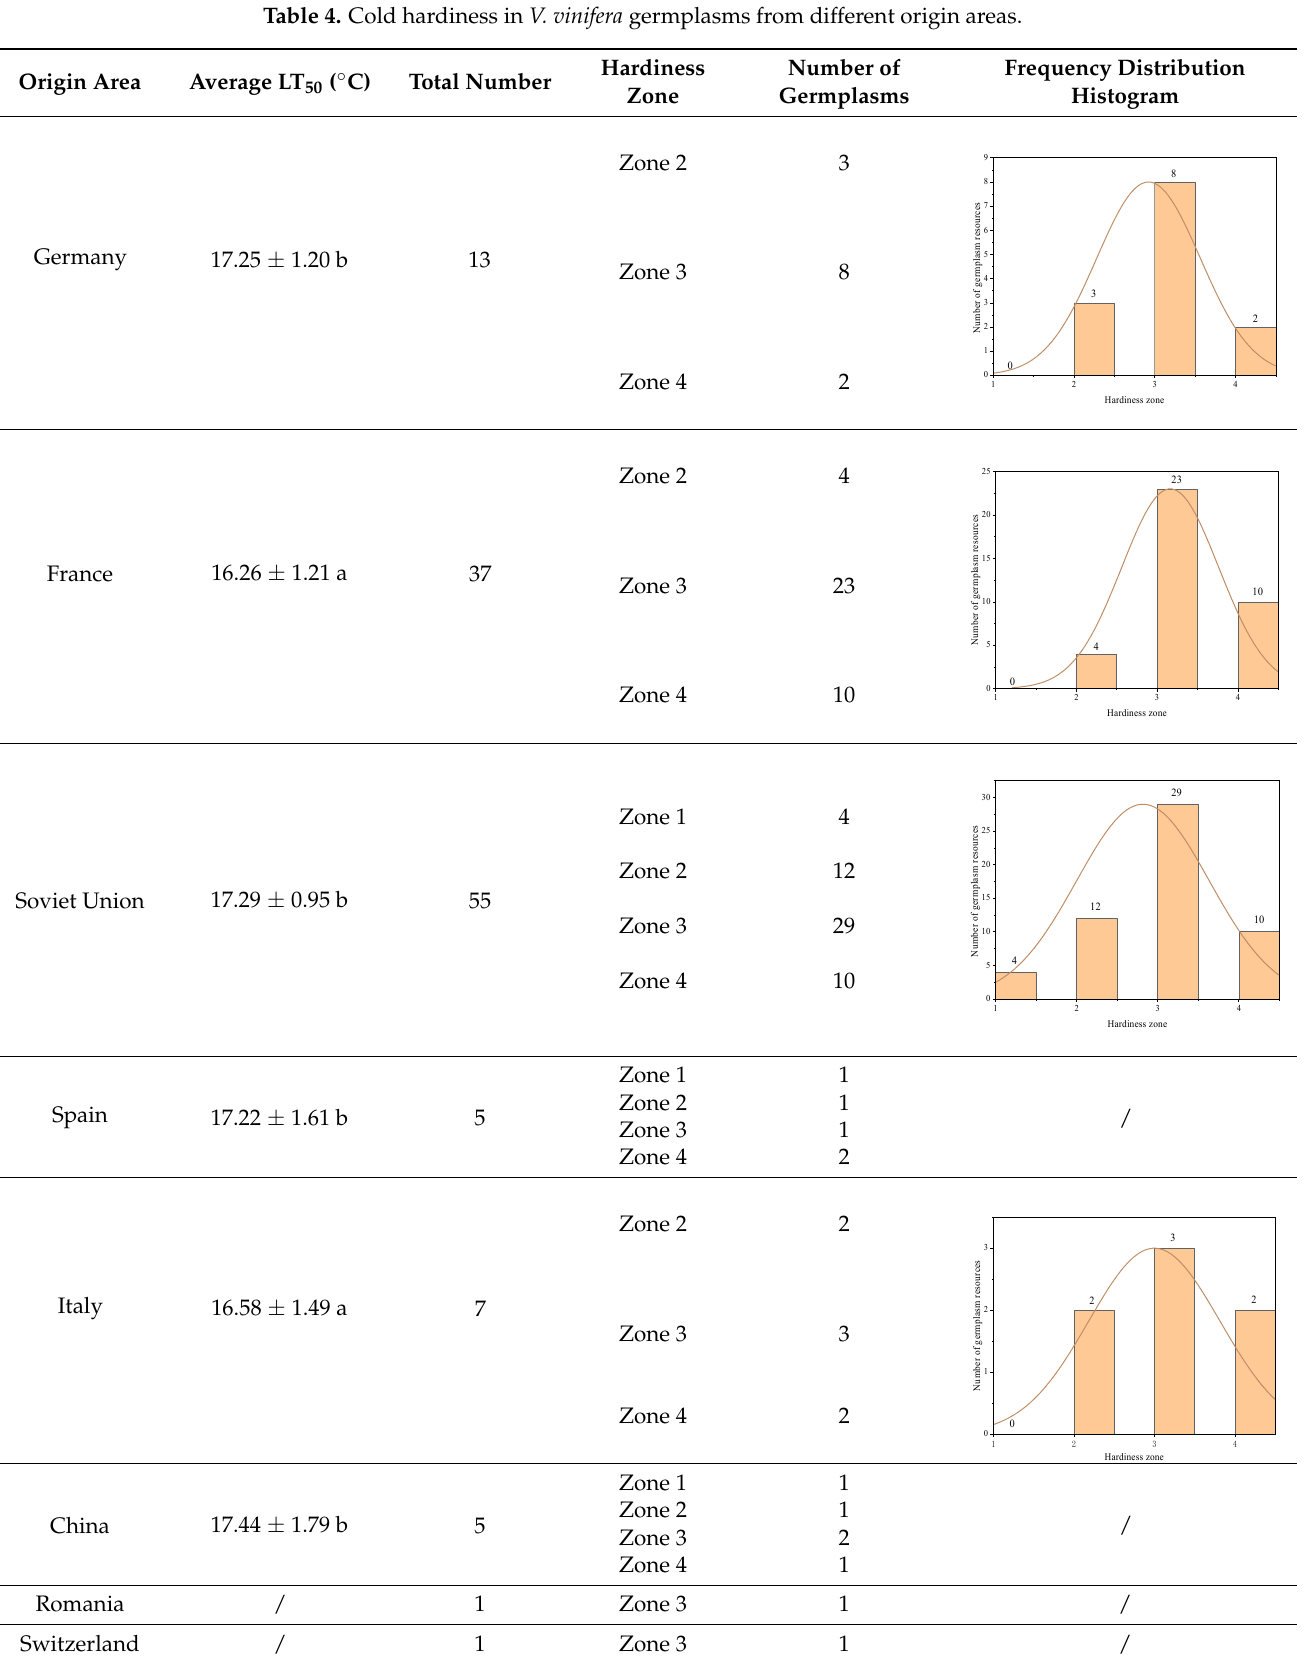
Table 4. Cold hardiness in V. vinifera germplasms from different origin areas.